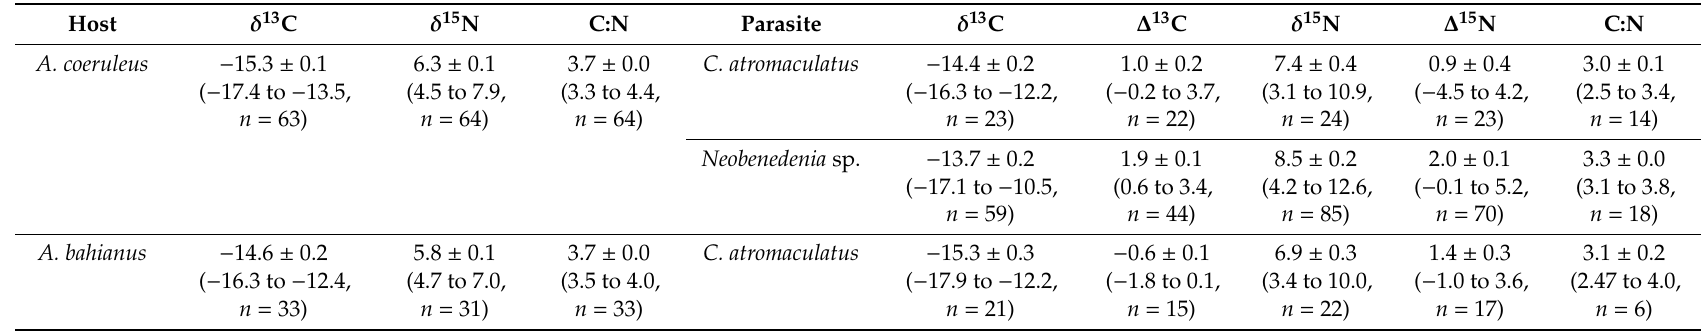
Table 2. Summary of stable isotope data (% (cid:24) , mean ± SE, range in parentheses), discrimination factors ( ∆ 13 C, ∆ 15 N), carbon to nitrogen ratios (C:N), and sample sizes ( n ) for host fish blood and